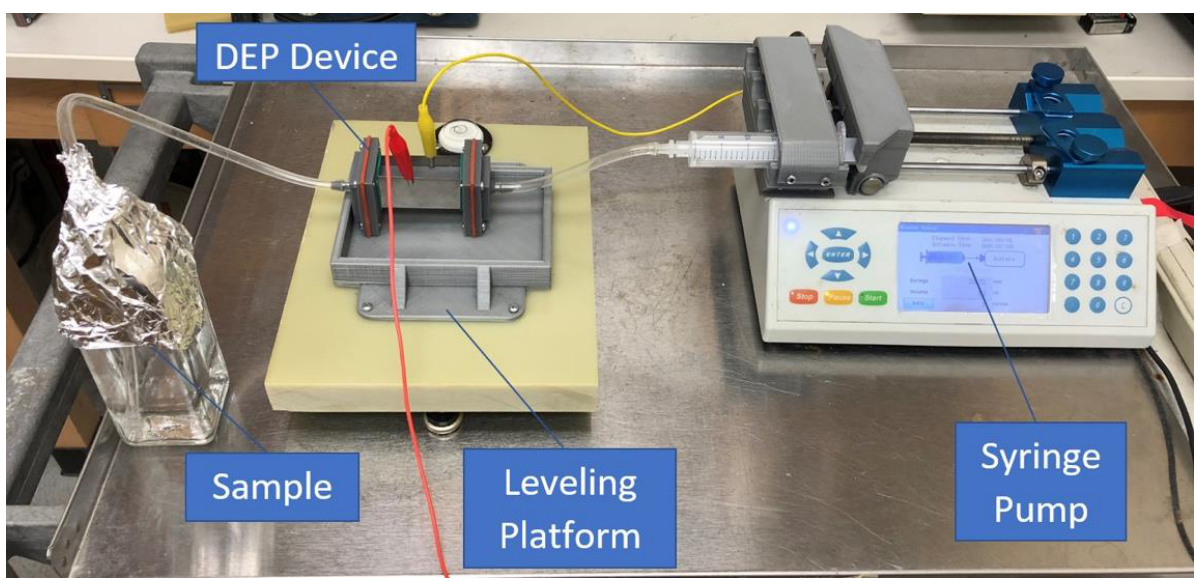
Figure 5. The iDEP device was placed on a leveled platform with a syringe pump attached to ensure a continuous flow of the sample through the device.